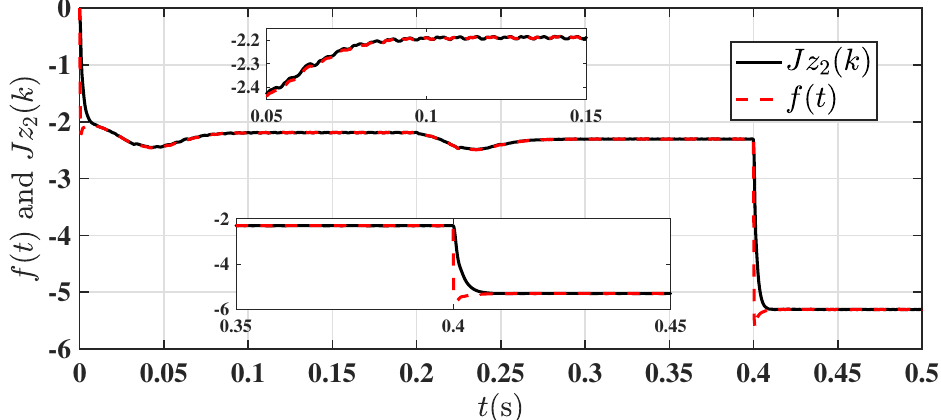
Figure 7. The lumped disturbance f ( t ) with the designed ESO-based estimate